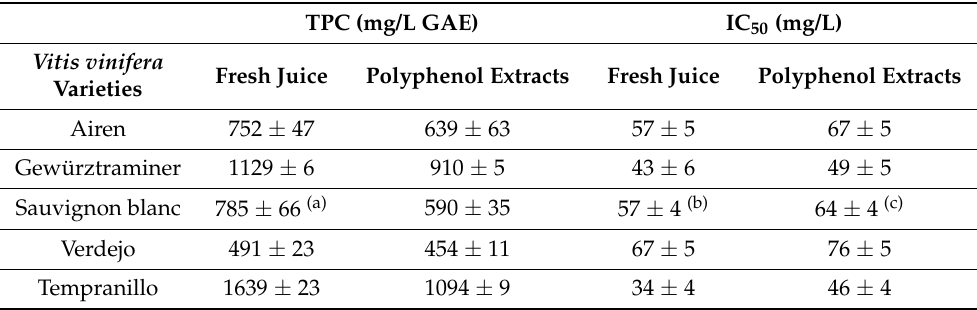
Table 2. Total polyphenol content (TPC, expressed in mg/L GAE ± standard deviation) and DPPH scavenging activity (IC 50 , expressed in mg/L ± standard deviation) of the fresh juice and polyphenol extracts. All the comparisons between the Airen and the rest of varieties were statistically significant ( p -value < 0.01), except for the Airen and Sauvignon Blanc TPC in fresh juice with a p -value = 0.0762 (a) , the IC 50 values in fresh juice, p -value = 0.99984 (b) , and the polyphenol extract, p -value = 0.62657 (c)